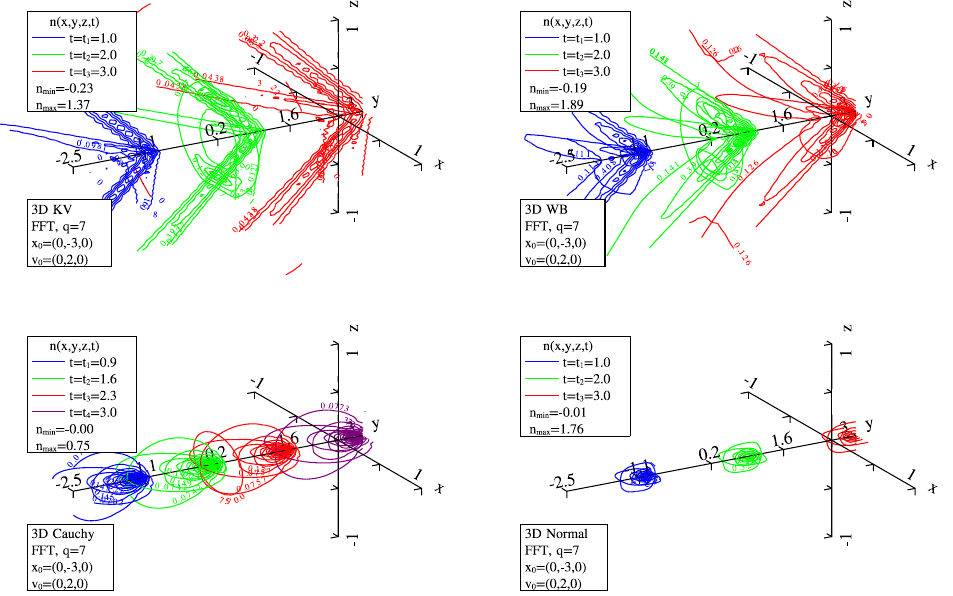
FIG. 5. The density n ð ~ x ; t Þ for the KV, WB, normal, and Cauchy distributions in 3D